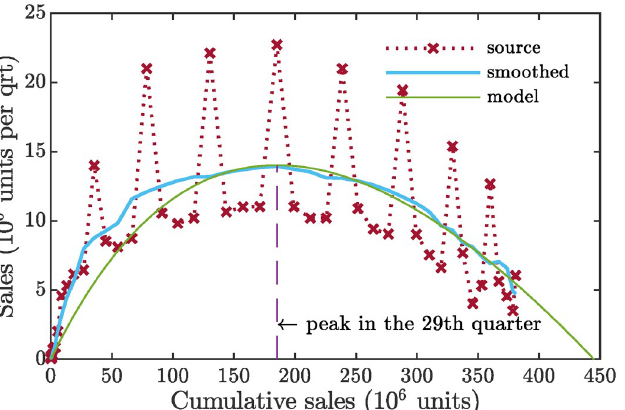
Fig 4. Apple’s iPod penetration chart (2002–2014) in the context of the model (21). A raw time series, _ y ð i ¼ 1 ; ... ; 49 Þ , representing quarterly sales of iPod (in million units) over a period covering 49 consecutive i quarters can be found on website [73]. It is the following set of figures: {0.125, 0.057, 0.054, 0.14, 0.219, 0.078, 0.304, 0.336, 0.733, 0.807, 0.86, 2.016, 4.58, 5.311, 6.155, 6.451, 14, 8.526 8.111, 8.729, 21, 10.549, 9.815, 10.2, 22.121, 10.644, 11.011, 11.022, 22.722, 11.01, 10.2, 10.2, 21, 10.89, 9.41, 9.051, 19.45, 9.02, 7.535, 6.62, 15.397, 7.673, 4.02, 5.344, 12.679, 5.633, 4.569, 3.498, 6.049}. This series first was subject to smoothing by taking the moving average over a four-quarter sliding window, and then fitted by the Eq (21).